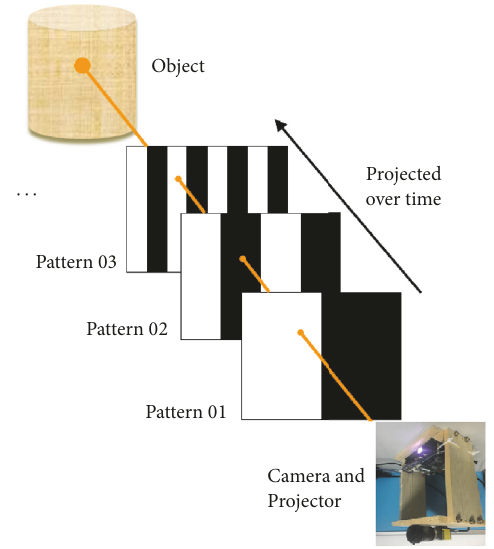
Figure 5: The acquisition of the projected patterns on an object. The gray-code pattern is projected by the projector and the scene is captured by the camera